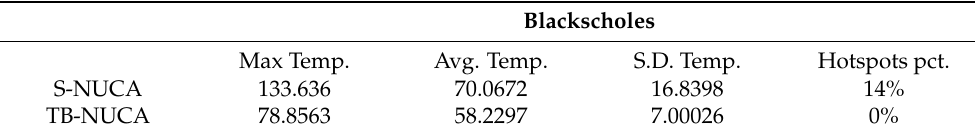
Table 4. Performance of blackscoles under TB-NUCA and S-NUCA mapping